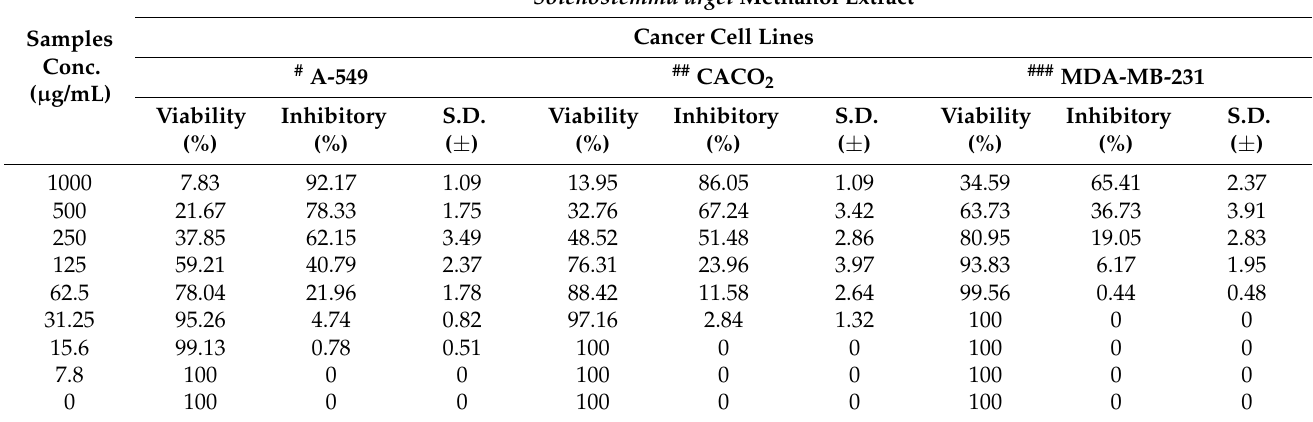
Table 5. Anticancer activity of Solenostemma argel methanolic extract at different concentrations toward different cancer cell